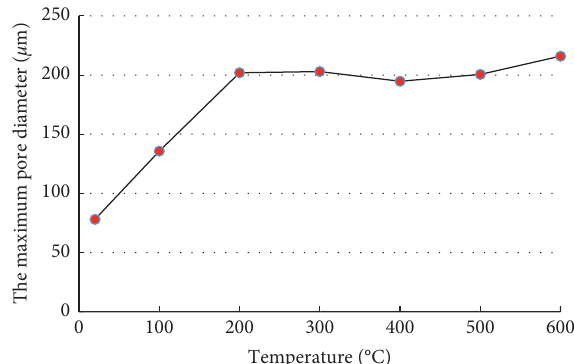
Figure 10: Variation in the maximum pore diameter with